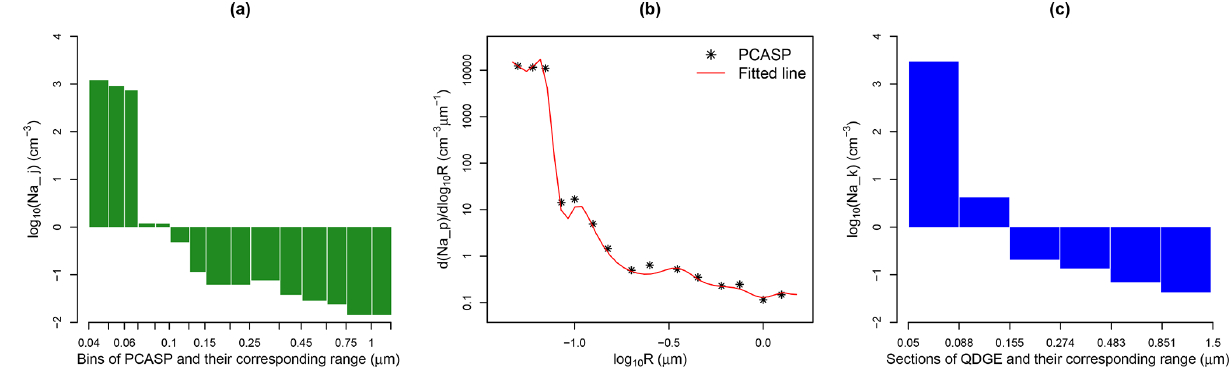
Figure 6. The processing of the observed aerosol number-size distribution for the input to the QDGE scheme: (a) the observed aerosol number concentration in each size bin sampled by PCASP, (b) the particle size distribution curve (red line) fitted to the observations (the asterisks refer to the observations that were derived from panel a ), and (c) aerosol number concentration in six size sections, as prescribed in model simulations with the QDGE